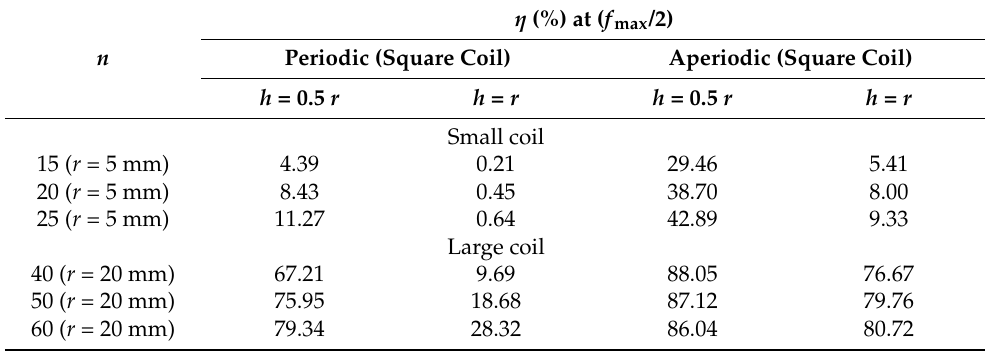
Table 8. The values of the power transfer efficiency at 500 kHz for a square coil (periodic and aperiodic).